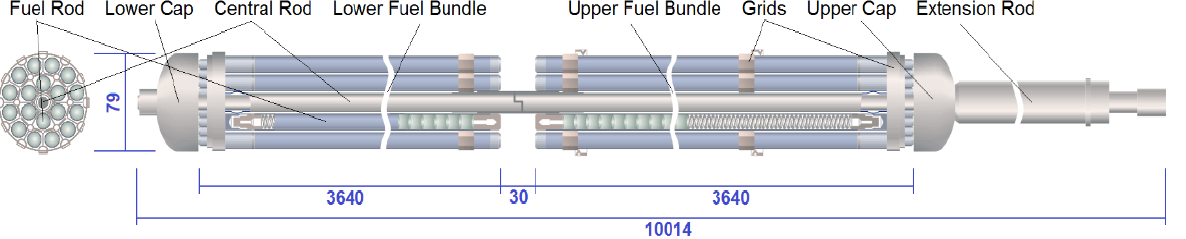
Figure 2. RBMK-1500 fuel assembly.